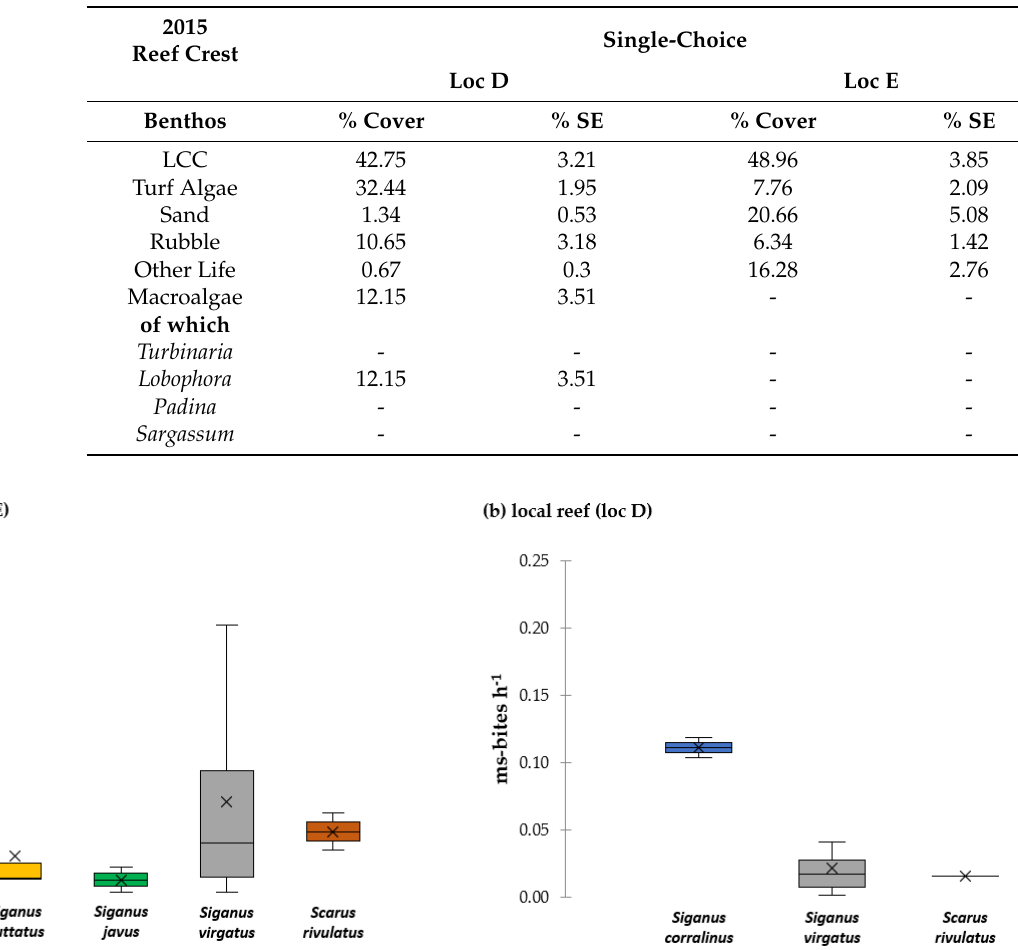
Table 1. Benthic community composition on the reef crest in the local reef (loc D) and the marine park (loc E) in 2015. Given are % of total cover for live coral cover (LCC), turf algae, sand, rubble, other life and macroalgae, whereas macroalgae are split into the genera Turbinara, Lobophora, Padina and Sargassum . Replicate number n = 12 at loc D and n = 9 at loc E.